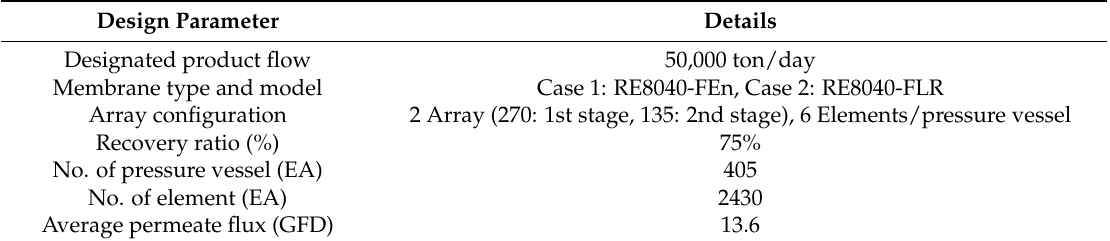
Table 7. Design parameters for the simulation study to estimate the LPRO feasibility.